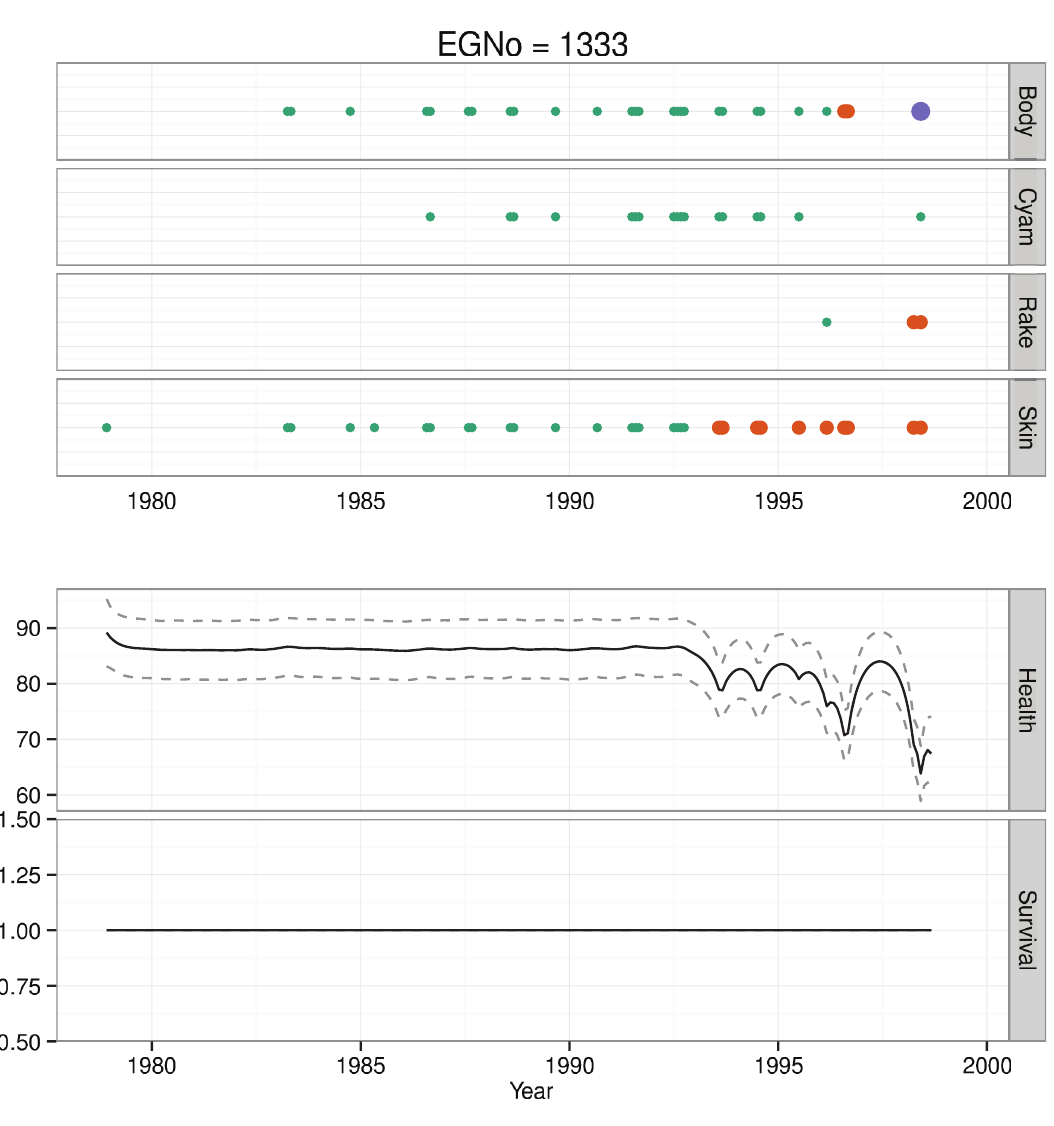
Figure 8. Health time series for whale # 1333. Time series of health observations H for skin condition, body condition, cyamids and rake marks (circles), estimates with uncertainty of health h (thick line and dashed lines), and estimates of survival s (height rectangle at bottom) for # 1333. Photographic observations of H are color and size coded by class. For a visual health parameter with three categories, e.g., body condition, green is the best category, orange is fair, and purple is poor. For a visual health parameter with two categories, e.g., skin condition, green is the best category, while orange is poor. # 1333 had a gradual decline in health over a period of years, and was observed dead in 1998.